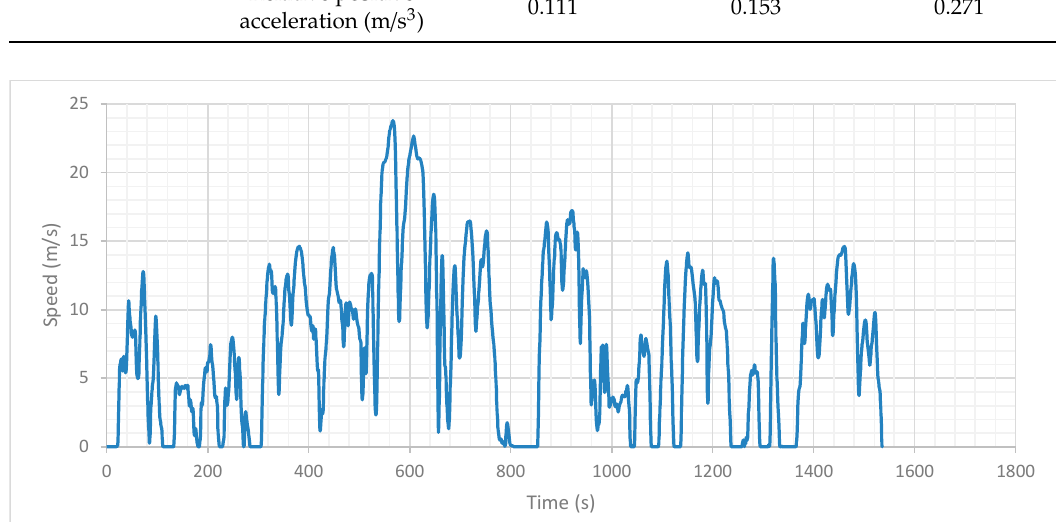
Figure A1. Speed profile of the ALDC.